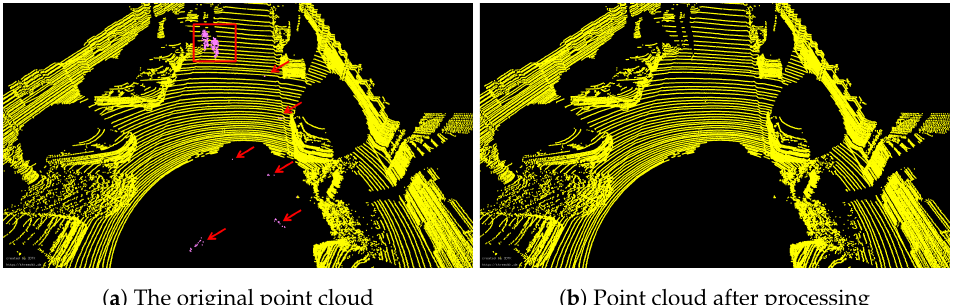
Figure 4. Removing dynamic objects and outliers in the point cloud, which is from a certain point cloud of sequence 00. ( a ) Point cloud with dynamic objects. The pink part indicates dynamic objects, i.e., bicyclist, which is marked by the red rectangle and outliers (marked by red arrows). ( b ) Point cloud after removing bicyclists and